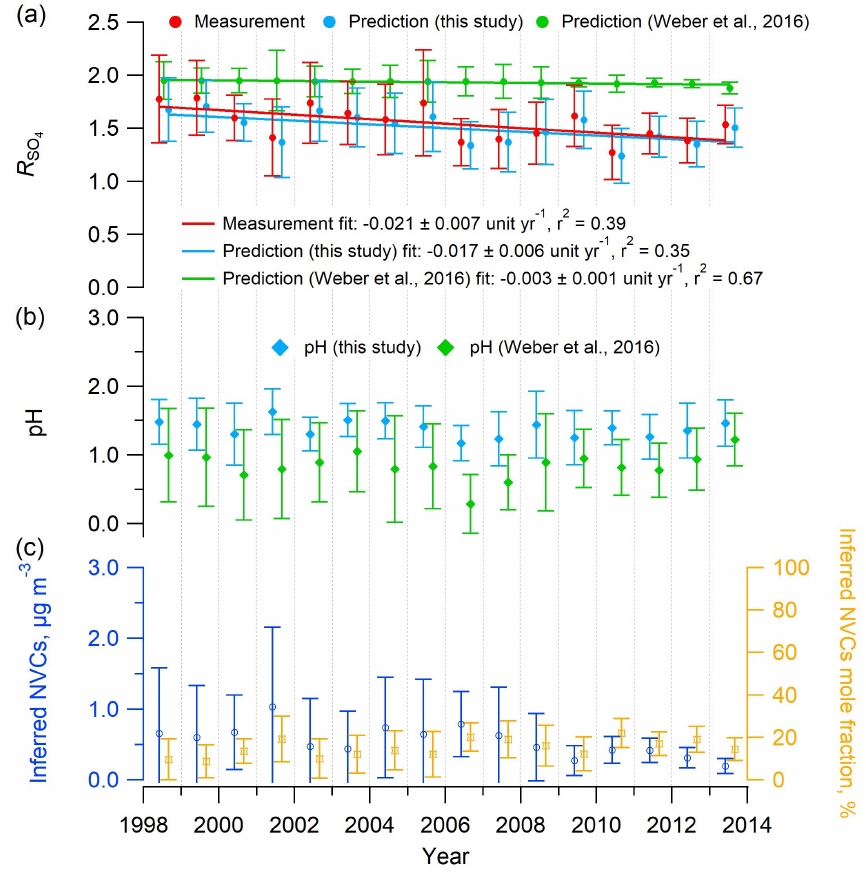
Figure 6. Mean summer (June–August) trends in (a) measured and predicted R SO , (b) predicted PM 2 . 5 pH, and (c) inferred NVCs concen- 4 tration and mole fraction at the SEARCH CTR site. Na + was inferred from an ion charge balance of Na + –NH + –SO 2 − –NO − . ISORROPIA 4 4 3 inputs include the measured PM 2 . 5 composition (NH + , SO 2 − , NO − ) and meteorological data (RH, T ) at CTR. In all cases, R SO and pH 4 4 3 4 were estimated with ISORROPIA II run in forward mode with an assumed NH 3 level of 0.36µgm − 3 , which is the mean concentration from the SOAS study (CTR site, summer 2013), due to limited NH 3 data before 2008. Historical NH 3 mean summer concentrations at CTR were 0.2µgm − 3 (2004–2007) (Blanchard et al., 2013) and 0 . 23 ± 0 . 14µgm − 3 (2008–2013) (Weber et al., 2016). Error bars represent daily data ranges (SD). Linear regression fits are shown and uncertainties in the fits are 1 SD. A total of 41 data points out of 609 (7%) with observed daily mean R SO above 3 were considered outliers and not shown (if included the fit slope is − 0 . 023 ± 0 . 008unityr − 1 4